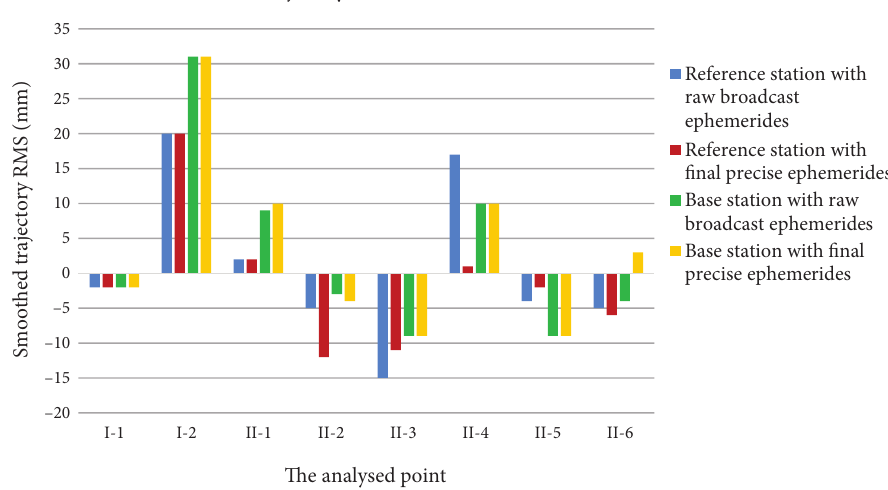
Figure 5. Smoothed trajectory estimated elevation RMS in analysed points, using four different schemes in trajectory calculation (Annok, 2019)